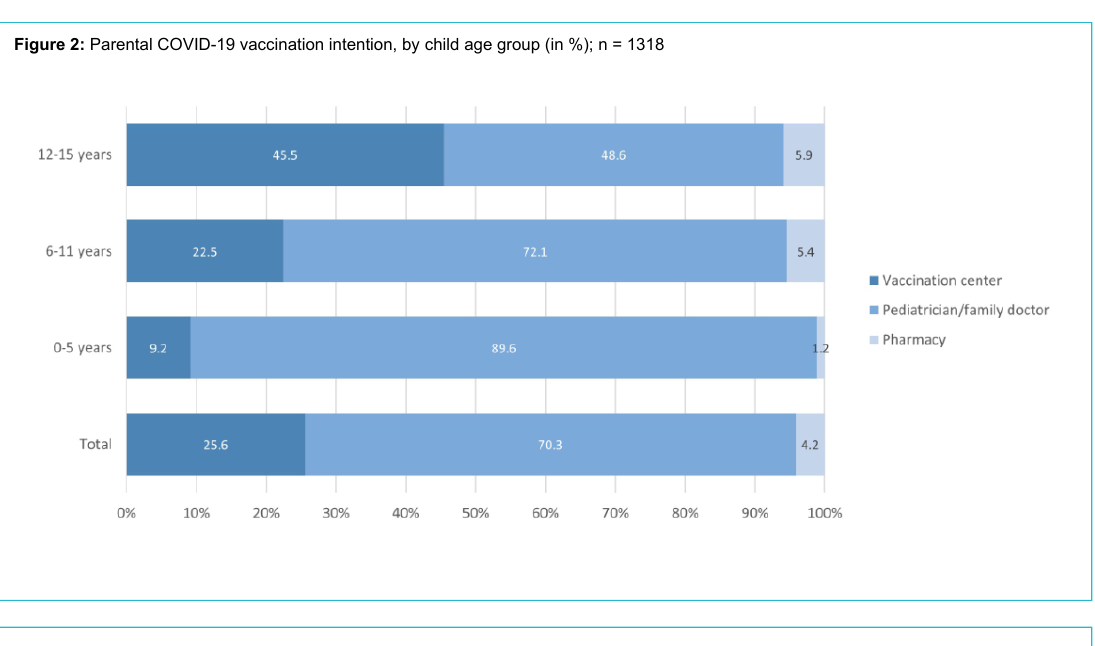
Figure 3: Parental preferred COVID-19 vaccination location for their child, by child age group (in %); n =